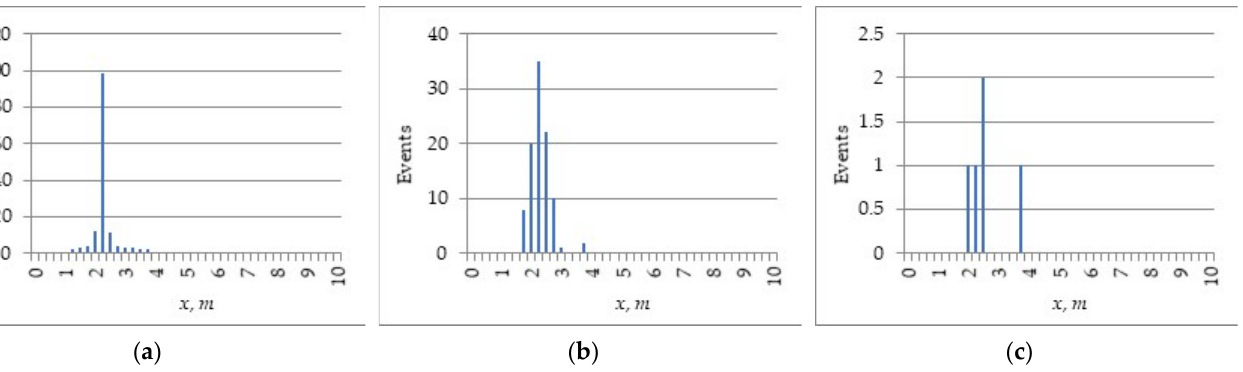
Figure 11. Result of AE source location with different amplitude thresholds: 30 dB ( a ), 35 dB ( b ) and 40 dB ( c ).